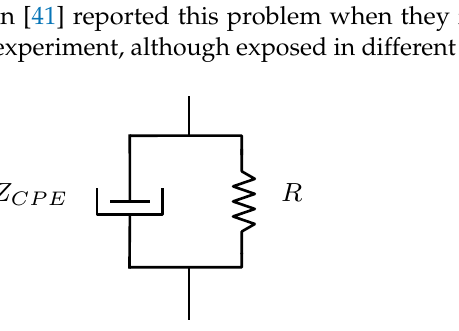
Figure 2. Electric equivalent of electrode impedance based on the element of the constant phase Z CPE